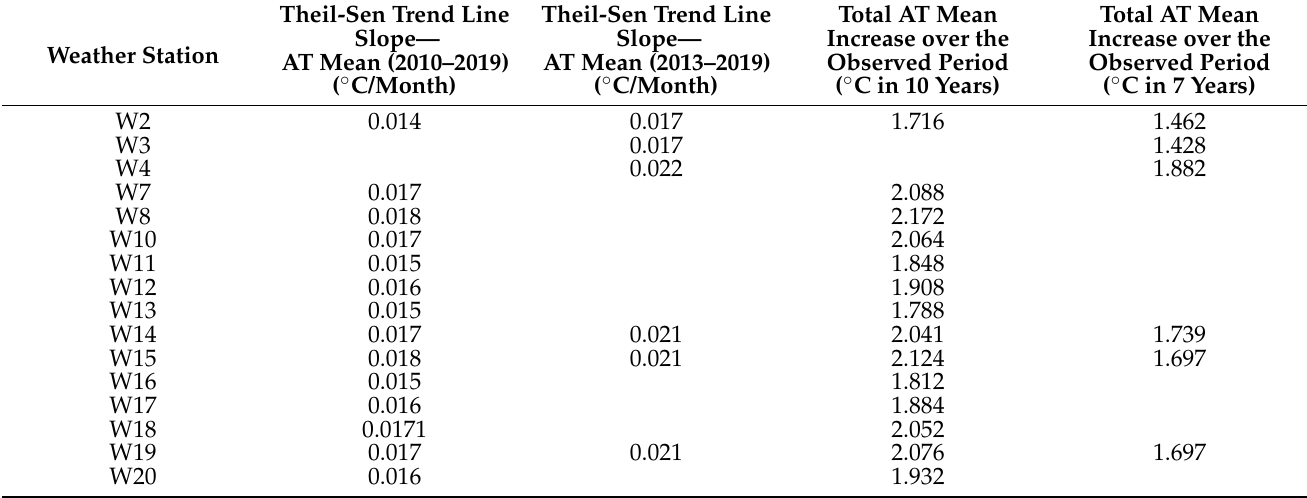
Table 1. Summary of monthly mean statistical data for GWT (mean, mean absolute maximum, mean absolute minimum and standard error) for the observed monitoring wells.